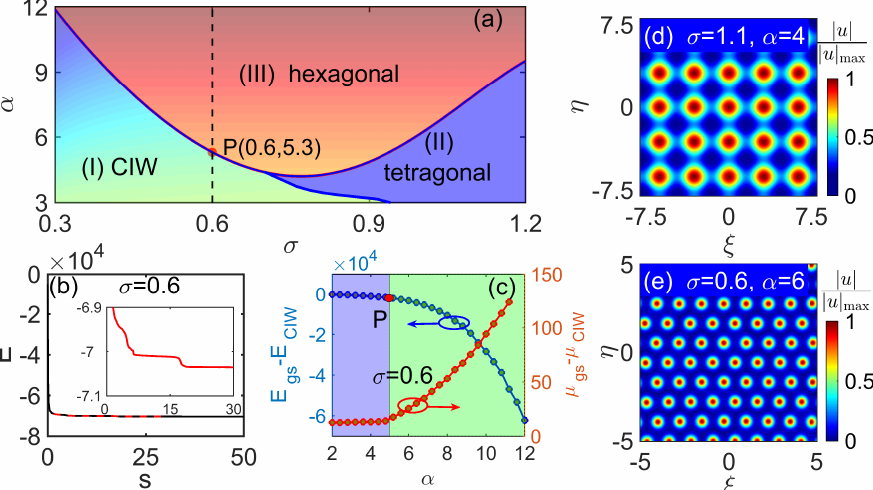
Figure 4. Pattern formation and the corresponding phase diagram for the case of PT -symmetric periodic potential: ( a ) phase diagram represents the emergence of the different phases from the constant intensity wave (CIW) solution to the tetragonal lattice (purple region II) and hexagonal lattice(red region III) as functions of nonlocality degree σ and nonlinear interaction strength α ; the vertical dotted line crossed from the point “P”, i.e., P ( 0.6,5.3 ) , corresponds to the σ = 0.6, and α from 3 to 12; ( b ) Hamiltonian energy for difference propagating distance s = z /2L diff ; the partially enlarged drawing inside the inset with a red line corresponds to the original curve with a red dotted line; ( c ) E gs − E CIW (blue) and µ gs − µ CIW (red) as functions of constant intensity amplitude α from 2 to 12 with σ = 0.6, where subscript “gs” and “CIW” mean the ground state and constant intensity wave, respectively; ( d , e ) two typical pattern formations in the system, i.e., tetragonal lattice (with α = 4 and σ = 1.1) and hexagonal lattice (with α = 6 and σ = 0.7), versus dimensionless ξ = x / R ⊥ and η = y / R ⊥ ; here, the probe field intensity is normalized by | u | / | u | max , V 0 = 1, R ⊥ = 4.5 µ m in ( d ) and 8 µ m in ( e